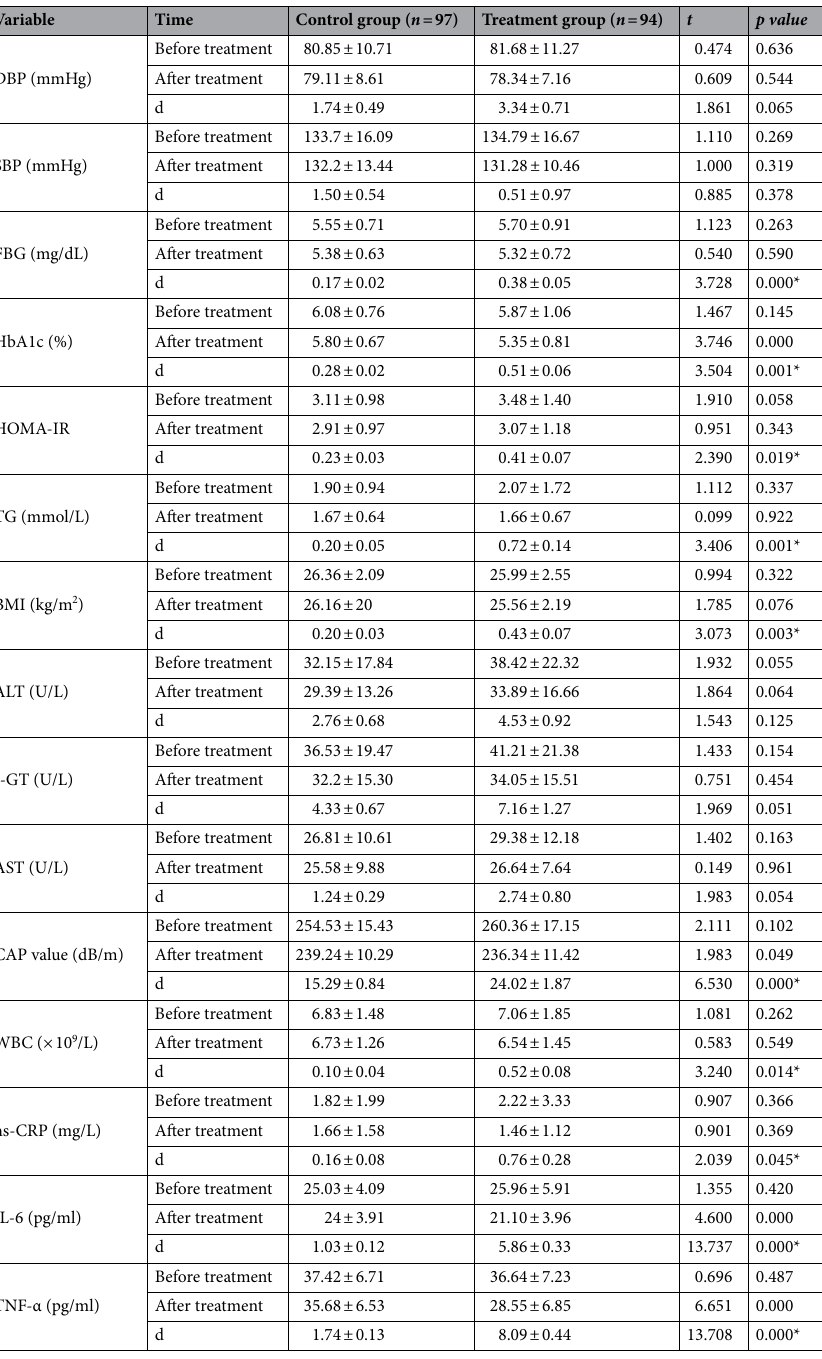
Table 3. Comparison of therapeutic effects between the treatment group and the control group. SBP systolic blood pressure, DBP diastolic blood pressure, BMI body mass index, WBC white blood cell, ALT alanine aminotransferase, γ-GT γ-glutamyltranspeptidase, AST aspartate aminotransferase, hs-CRP high-sensitivity C-reactive protein, FBG fasting blood glucose, HbA1c glycosylated haemoglobin, HOMA-IR homeostasis model assessment of insulin resistance, TG triglyceride, CAP controlled attenuation parameter, IL-6 interleukin 6, TNF-α tumour necrosis factor-α. * p value obtained from the SNK